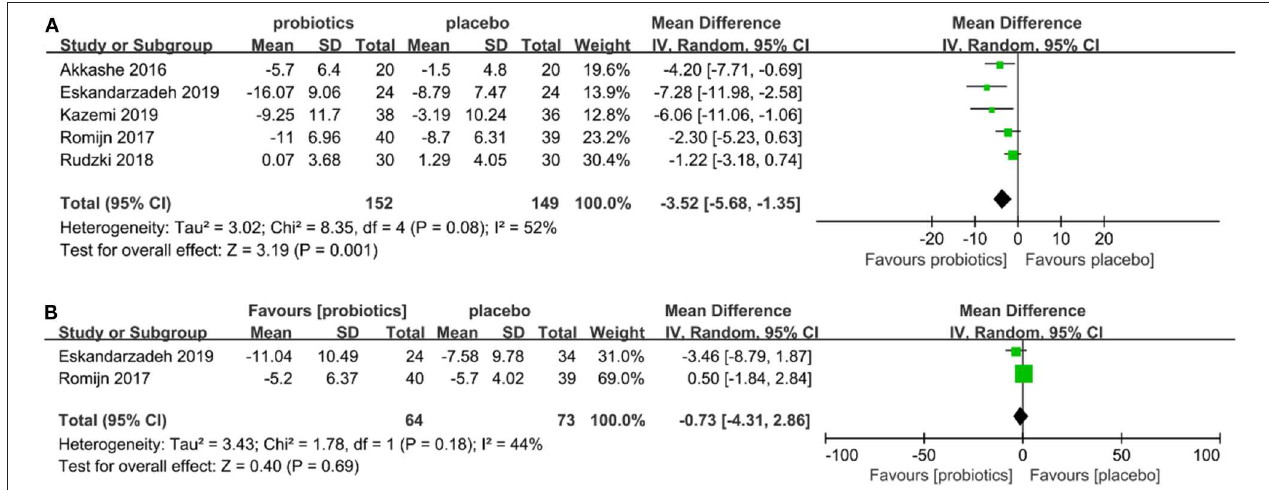
FIGURE 3 | (A) Forest plot showing depressive symptoms of probiotics in patients with depression or anxiety. (B) Forest plot showing anxiety symptoms of probiotics in patients with depression or anxiety.